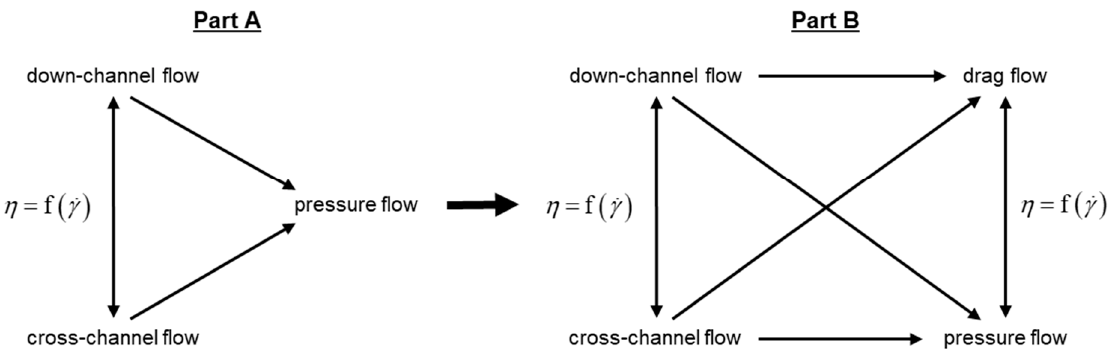
Figure 1. Research approach: In the first part (Part A), the pressure flow was decoupled from the drag flow. With the shear-thinning flow behavior being considered, a coupled network of down- and cross-channel flows was solved. In this part (Part B), the influence of the rotation is added.